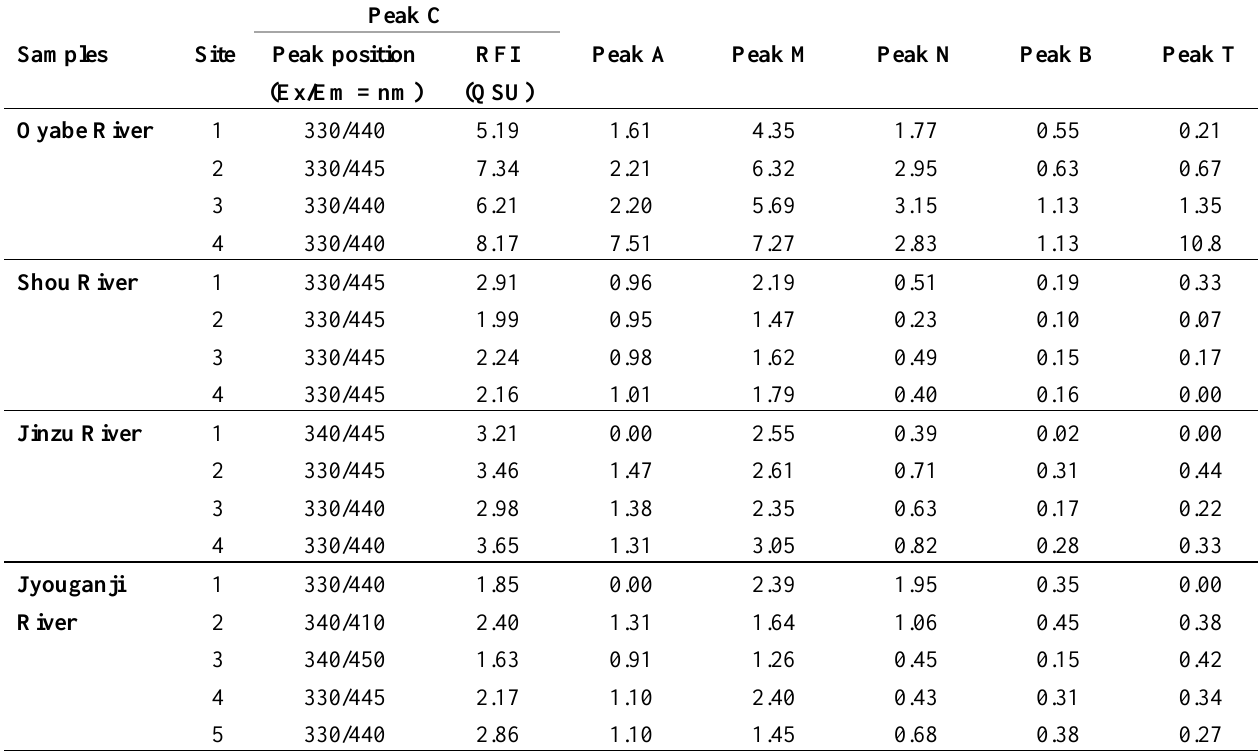
Table 2. The RFI of each peak obtained from 3DEEM spectra of the river water samples. The RFI values for peak A, peak M, peak N, peak B and peak T were obtained from the peak’s position at 240/420, 290/370, 280/370, 270/370 and 220/345 (Ex./Em.)